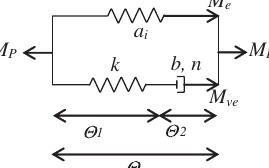
Fig. 3. Mechanical analogue of passive moment model. Two elas- tic elements are represented with model parameters k and a i , while parameters b and n characterize viscous element. Joint angle is rep- resented by (cid:3) , and M e , M ve and M P are nonlinear passive elastic moment,viscoelasticmomentandpassivemomentdevelopedatjoint respectively, from [1].